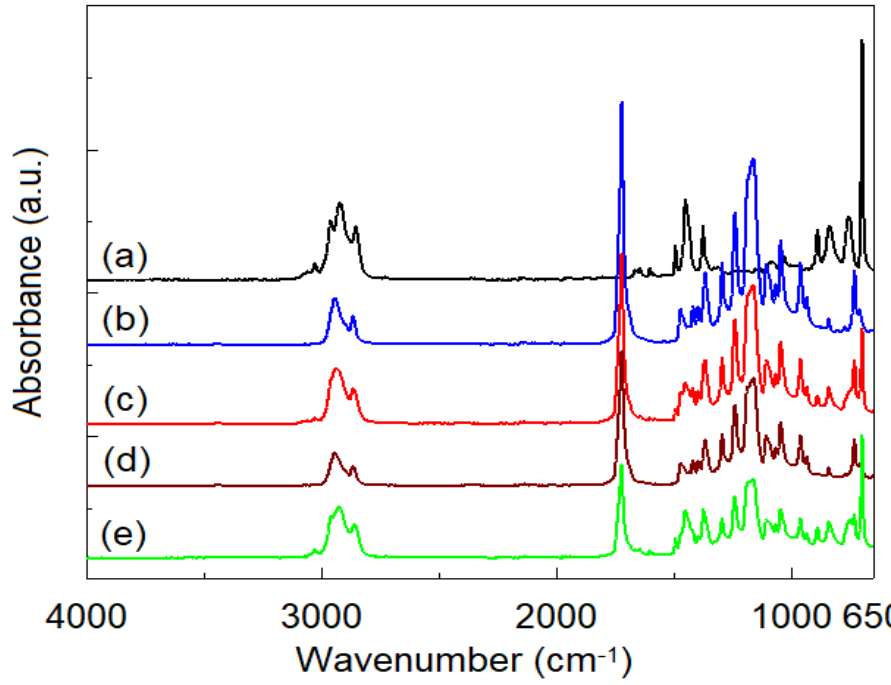
Figure 10. ATR/FTIR spectra recorded on: (a) SIS neat; (b) PCL neat; (c) SIS:PCL = 1:1; (d) SIS:PCL = 1:3; (e) SIS:PCL = 3:1 (Dose: 0 kGy).